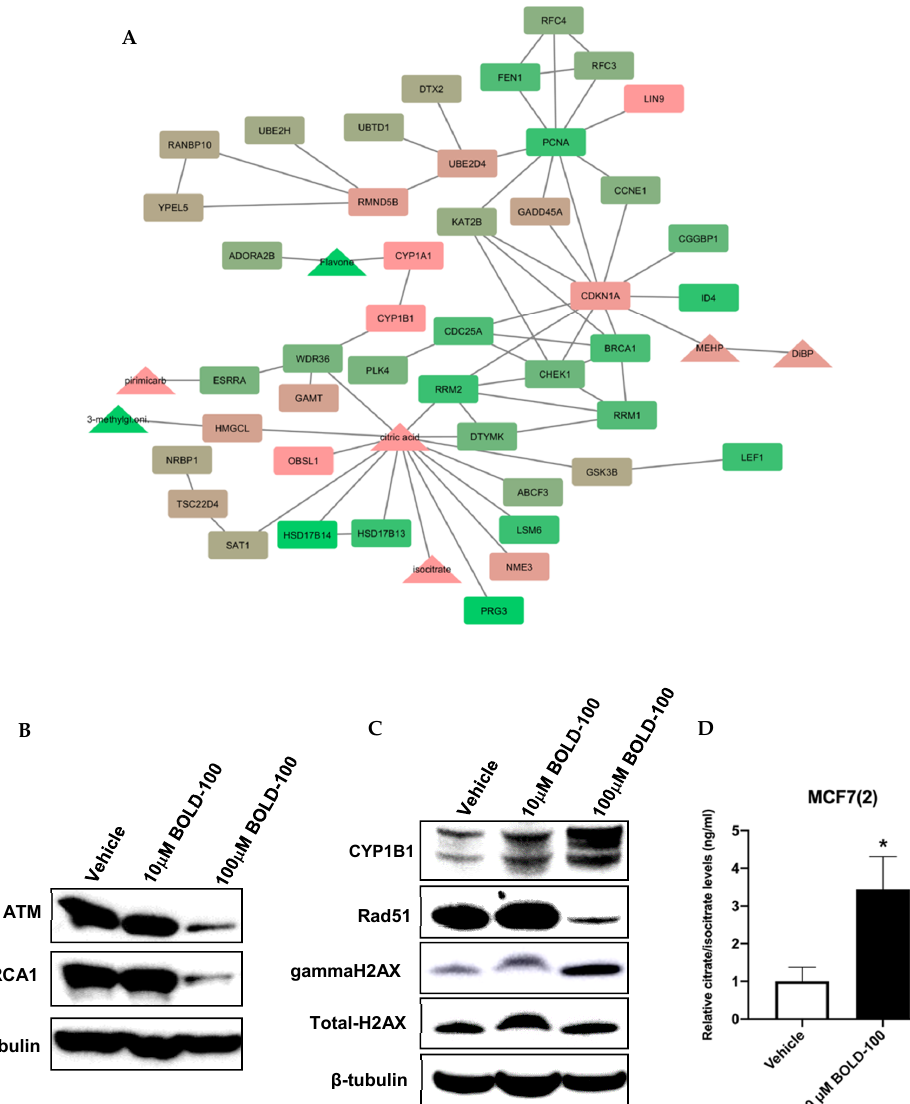
Figure 3. Integration and validation of significantly altered proteins in MCF7(2) cells treated with 100 µ M BOLD-100 for 72 h. ( A ) Network analysis of the top 2000 di ff erentially expressed (DE) genes, ranked by p -value. Each of the mutually exclusive networks of DE genes were input into STITCH along with all DE metabolites to integrate the gene and protein expression datasets and expand the networks to include common interacting neighbors from the STITCH database. The resulting networks for each DE set were integrated and pruned of both nodes not detected as di ff erentially expressed in the dataset including subnetworks isolated from the largest interconnected sets. The networks were visualized using Cytoscape, with genes represented as rectangles and metabolites as triangles, with the log2 fold change overlaid scaled from low (green) to high (red) expression. ( B – D ), Western blot analysis in cells treated with vehicle (DMSO), 10 µ M or 100 µ M BOLD-100 for 72 h show ( B ) ATM and BRCA1 protein levels were decreased with 100 µ M BOLD-100 treatment, ( C ) CYP1B1 and gamma-H2AX (marker of DNA double-strand break) was increased (total H2AX levels did not change) while RAD51 protein level was decreased with 100 µ M BOLD-100 treatment. For whole blots, please see Figures S3 and S4. ( D ) Mass spectrometry based quantitative measurement show significant (* p < 0.01, Student t -test) increase in citric acid and isocitrate following treatment with 100 µ M BOLD-100 in MCF7